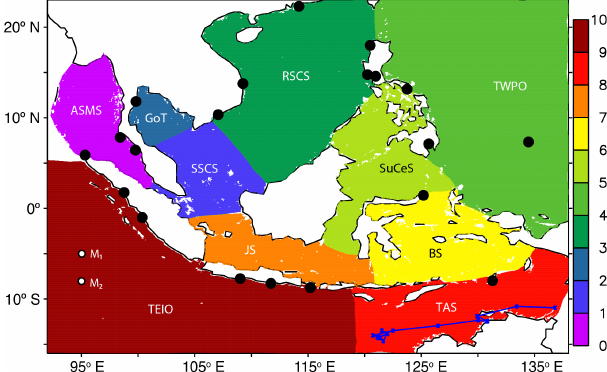
Celebes seas (SuCeS), (7) Banda Sea (BS), (8) Java Sea (JS), (9) Timor–Arafura seas (TAS), and (10) the tropical eastern Indian Ocean